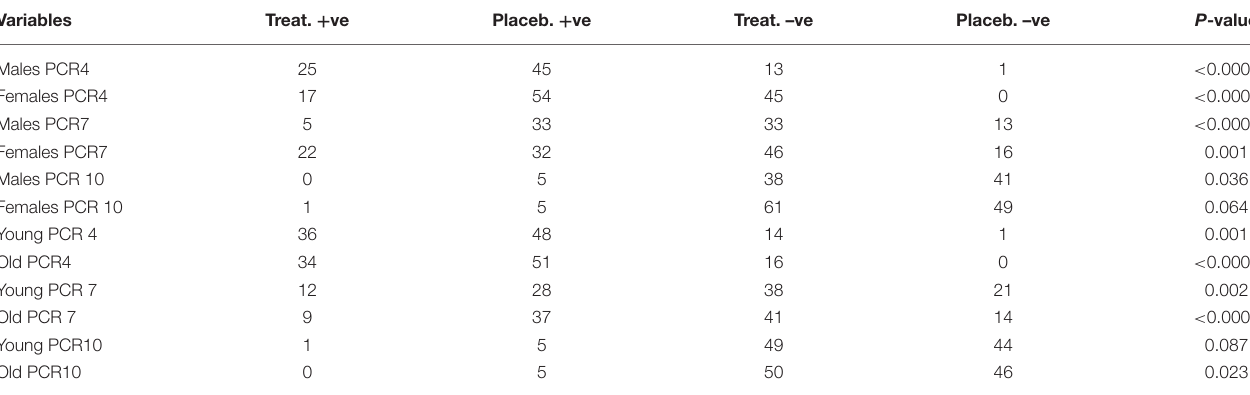
TABLE 4 | Effect of treatment on age and gender